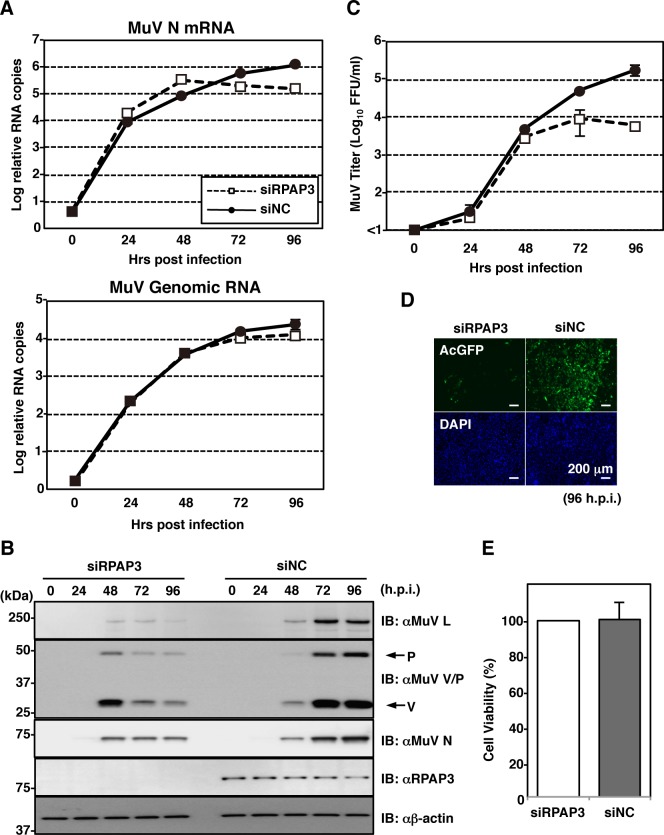
RPAP3 knockdown restricts MuV propagation.(A-D) At 48 h post-transfection with either siRPAP3 or siNC, A549 cells were infected with rMuV/AcGFP at a MOI of 0.05. Total cellular RNA and cell lysates were collected at 0, 24, 48, 72 and 96 hpi, and relative levels of viral RNAs and proteins were analyzed by qPCR (A) and immunoblotting (B), respectively. (C) Supernatants were collected at 0, 24, 48, 72 and 96 hpi, and infectious titers were determined by plaque assay. (D) At 96 hpi, cells were observed under a fluorescence microscope. (E) At 120 h post-transfection with siRPAP3, cell viability was determined and calculated as a percentage of the viability of cells transfected with siNC. Error bars indicate the standard deviations of triplicate wells.